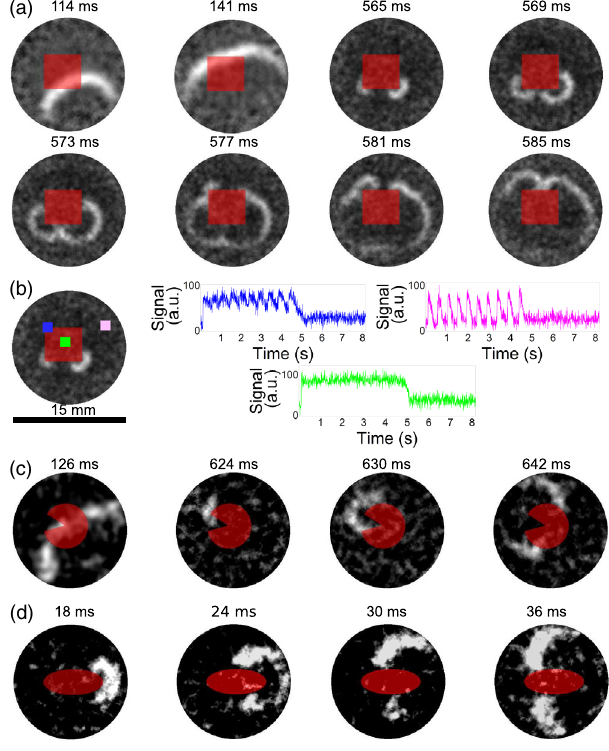
FIG. 1. Optogenetic induction of quasistable depolarized zones (red areas) leads to ectopic waves emanating from the most curved portions of the interface between tissue with ultralong and normal action potentials. (a) Time series of a single experiment showing ectopic waves originating from the corners of a square quasistable depolarized region after a first wave has passed. (b) Distribution of the oscillations amplitude during ectopic activity at the positions indicated by the green, blue, and magenta dot. (c) Generation of an ectopic wave from the “ jaw tip of a Pacman. ” (d) Generation of an ectopic wave from the vertex of an elliptic interface. In all figures, the symmetry is broken by the first wave passing through the